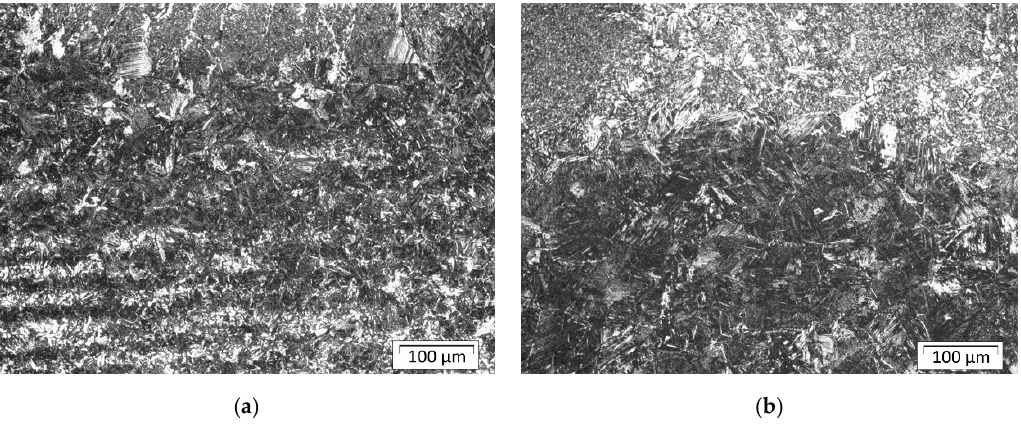
Figure 13. Sample A: ( a ) the structure of the HAZ in the axis of bead number six; ( b ) the structure of the HAZ between the fifth and sixth bead.